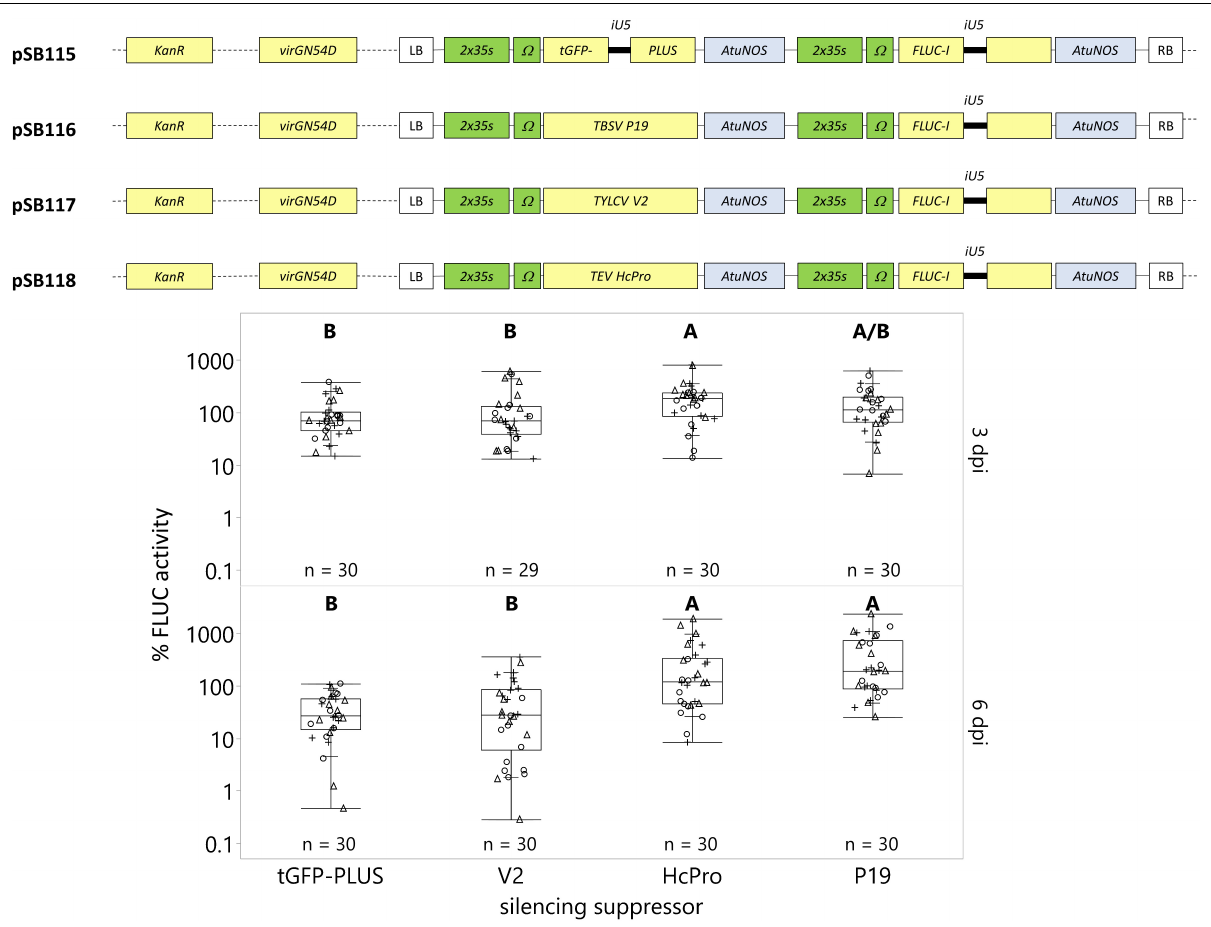
Frontiers in Plant Science |